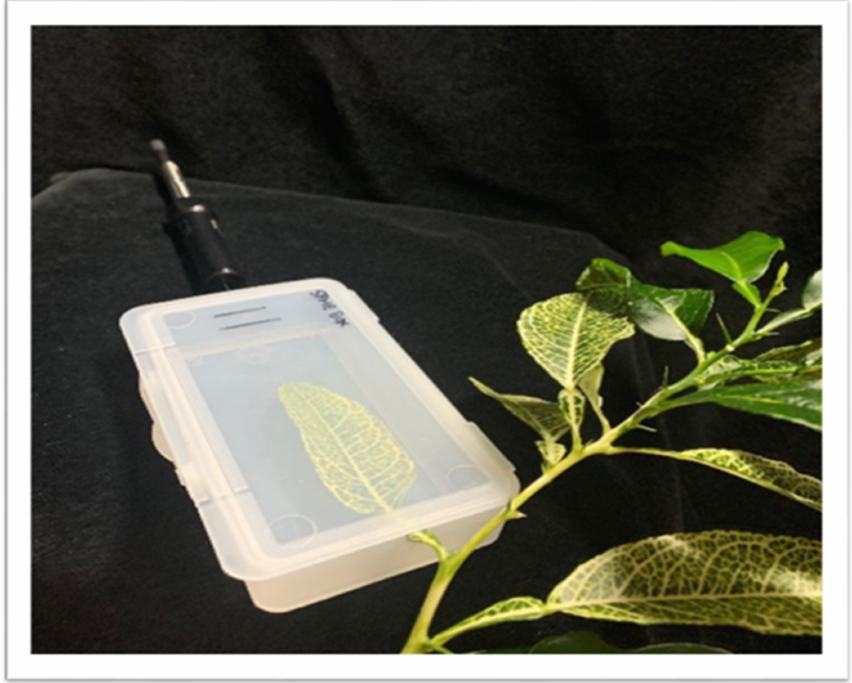
Figure 5. Collection of the released VOCs from citrus leaves using the overhead space. Leaf was placed lying flat inside a clear plastic box with a notch cut out at one end for the stem and a pinhole at the other end for fiber